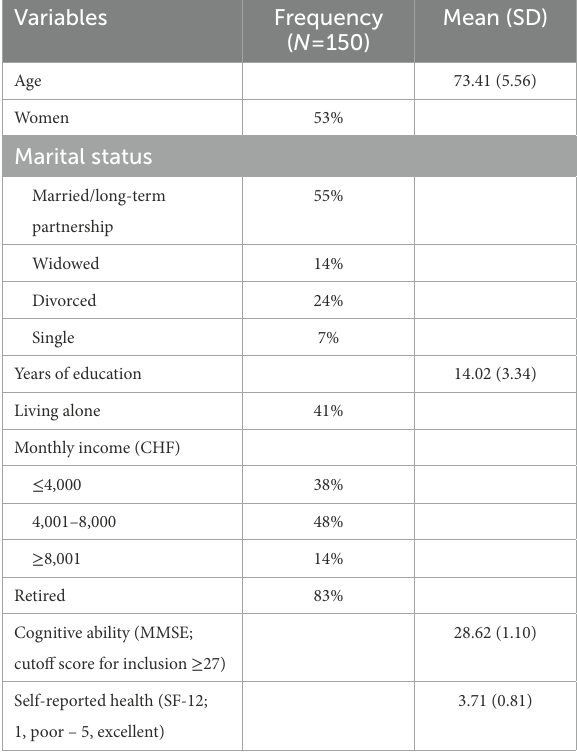
TABLE 1 Descriptive statistics of key sample